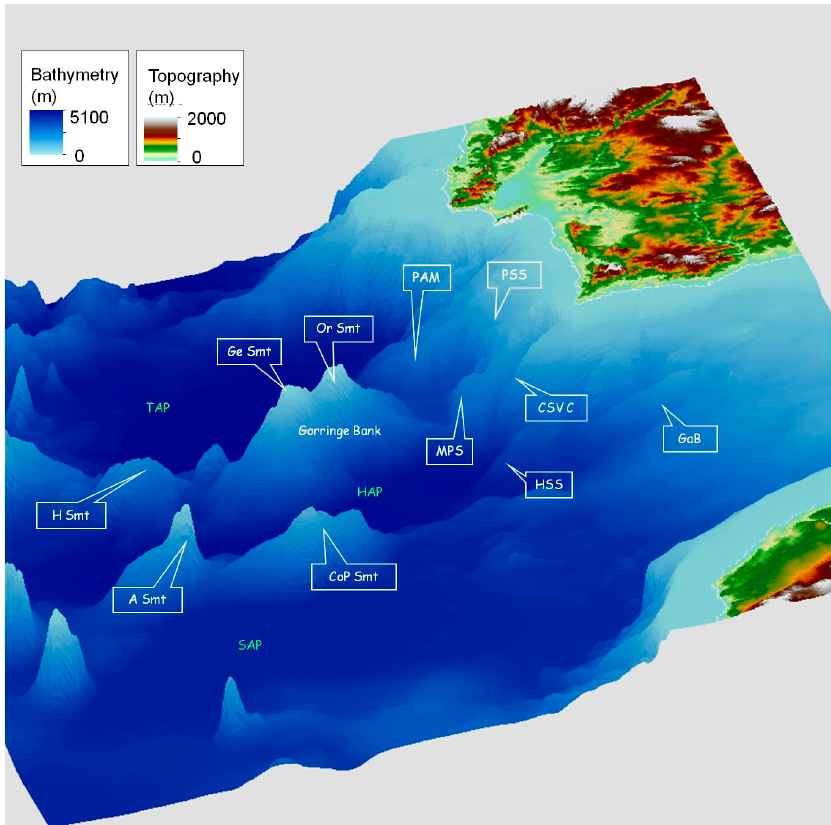
Figure 3. Portuguese continental margin represented in 3D. The most evident structure is the Gorringe Bank with 200 km in length. Abbreviations by alphabetical order are: A Smt: Ampere Seamount; CoP Smt: Coral Patch Seamount; CSVC: Cabo São Vicente Canyon; GaB: Guadalquivir Bank; Ge Smt: Gettysburg Seamount; HAP: Horseshoe Abyssal Plain; H Smt: Hirondelle Seamount; HSS: horseshoe Scarp; MPS: Marquês de Pombal Scarp; Or Smt: Ormonde Seamount; PAM: Principes de Avis Mountain; PSS: Pereira de Sousa Scarp; SAP: Seine Abyssal Plain. TAP: Tagus Abyssal Plain (adapted from [4]).